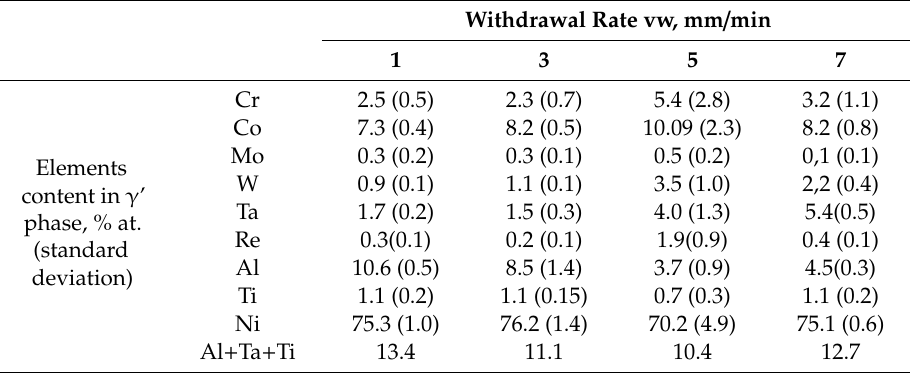
Table 3. Chemical composition of the γ ’ phase in CMSX-4 superalloy.